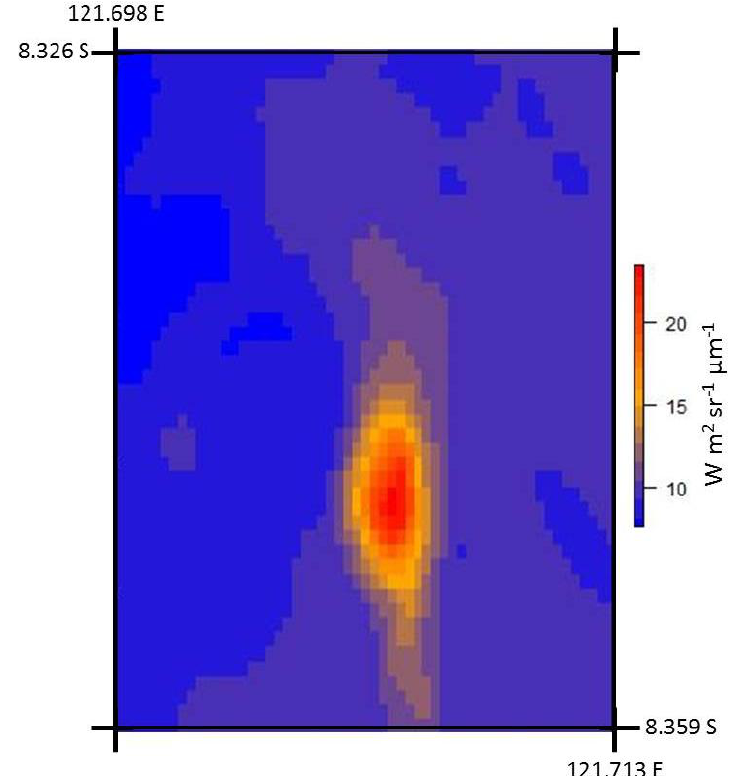
Figure 4. Top of atmosphere radiant signals associated with the extracted region (see Figure 1), for the TIRS band